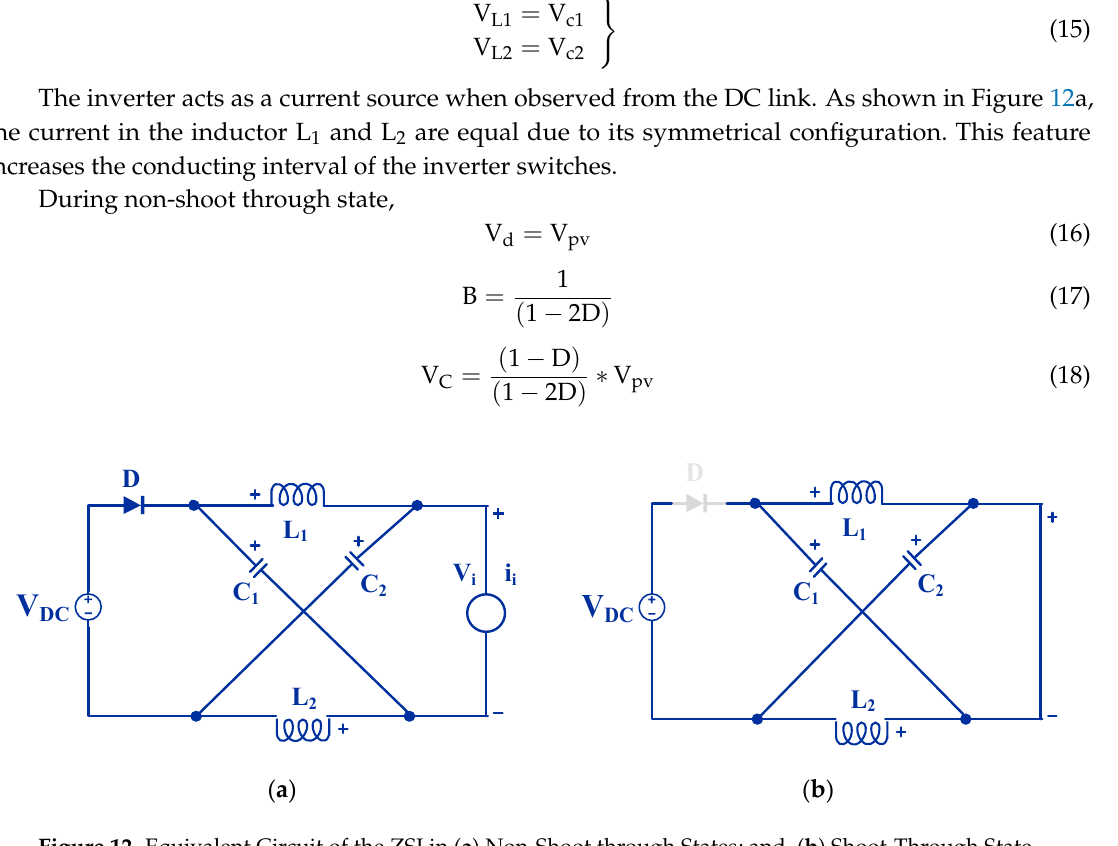
Figure 12. Equivalent Circuit of the ZSI in ( a ) Non-Shoot through States; and, ( b ) Shoot-Through State.